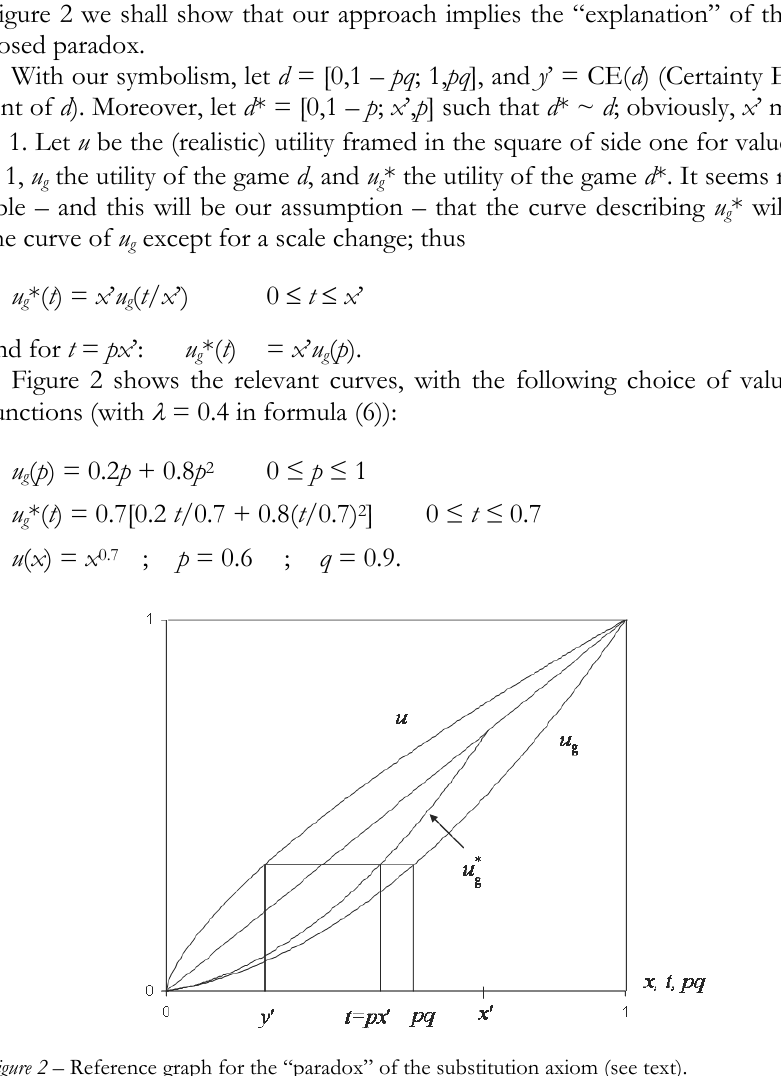
Figure 2 – Reference graph for the “paradox” of the substitution axiom (see